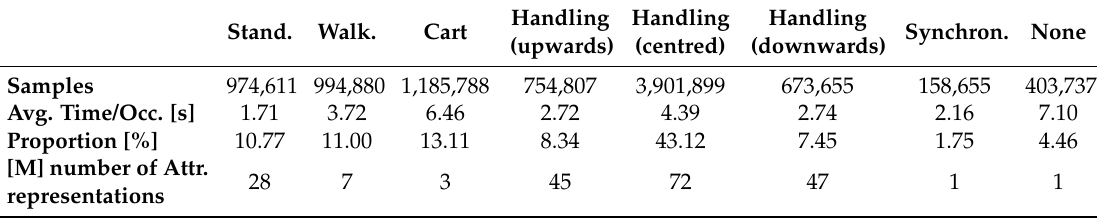
Table 7. Annotation results divided by activity classes.